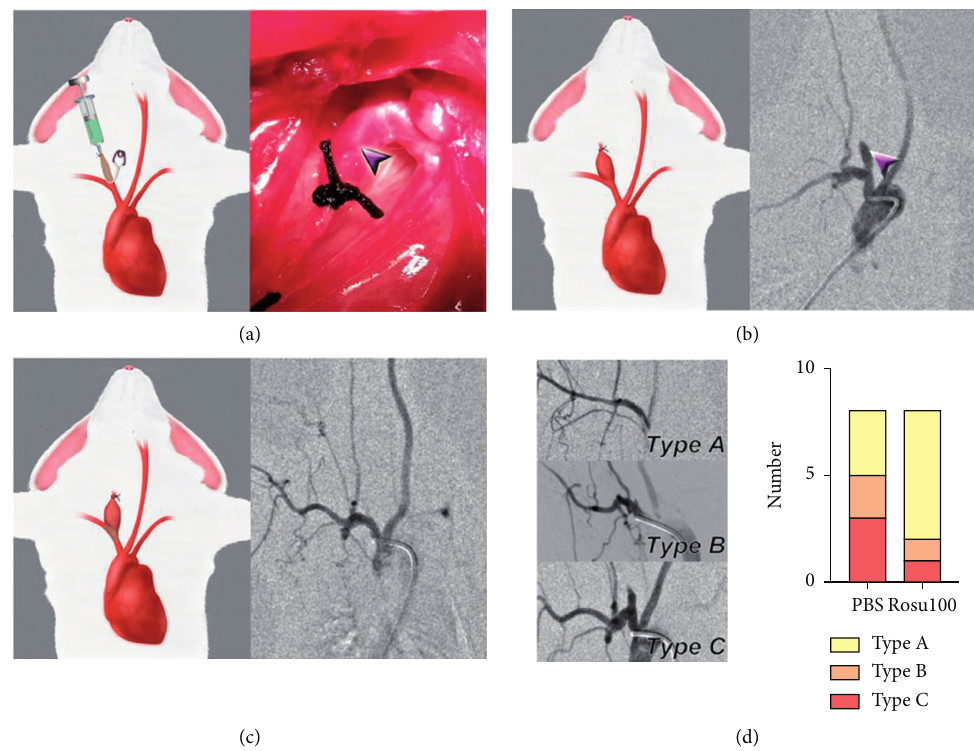
Figure 4: (a) Schematic illustration showing the creation of the rabbit aneurysm model and a photograph showing aneurysm (arrow) formation during operation. (b) Schematic illustration showing aneurysm formation and an angiograph showing aneurysm (arrow). (c) Schematic illustration and an angiograph showing aneurysm closure after stent implantation. (d) Angiograph illustration types A, B, and C in the long-term follow-up. Bar graph showing the number of different types in the Rosu 100 group vs the PBS group; reproduced with permission from